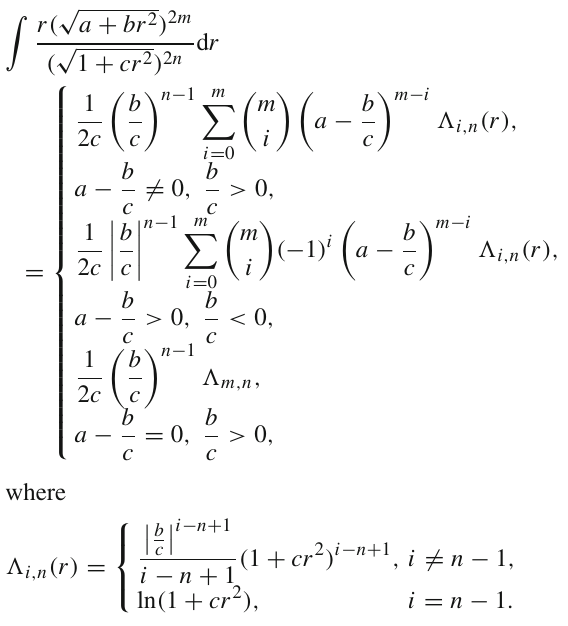
sphere generated by the particular choice of parameters may be considered potentially